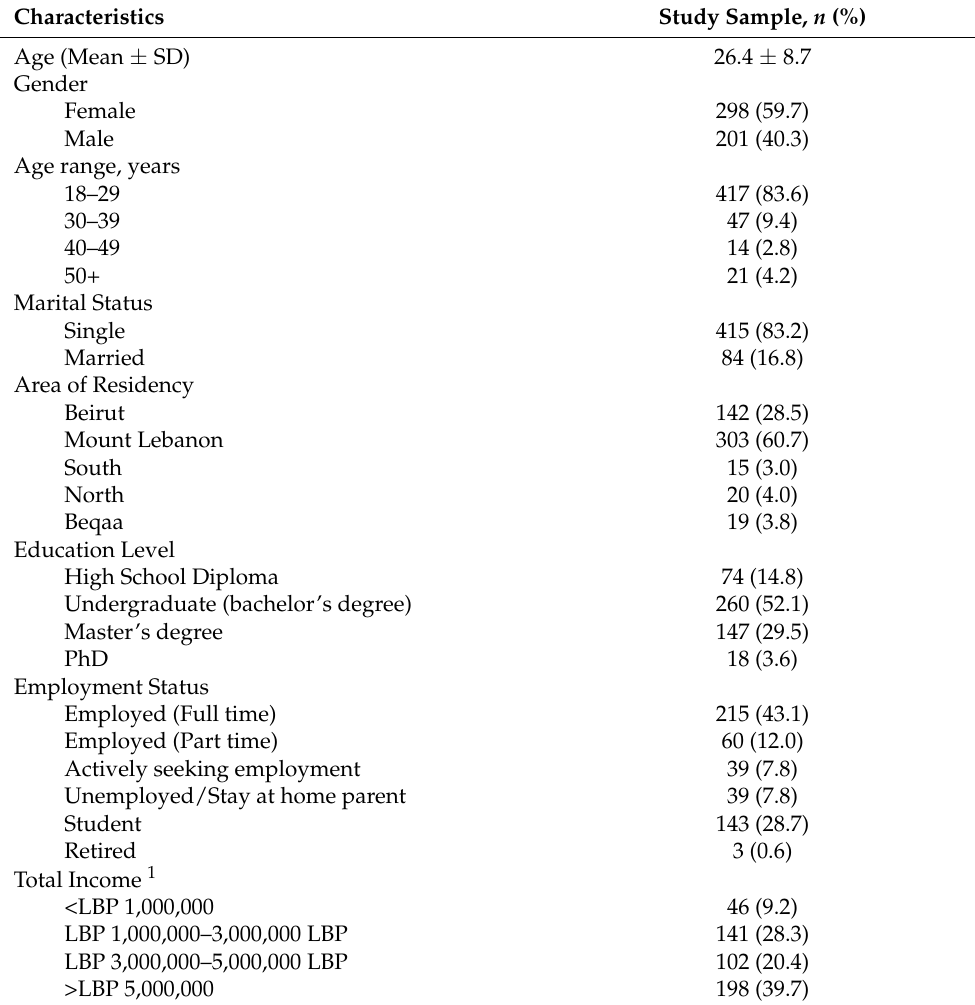
Table 1. Sociodemographic characteristics of study population ( n =